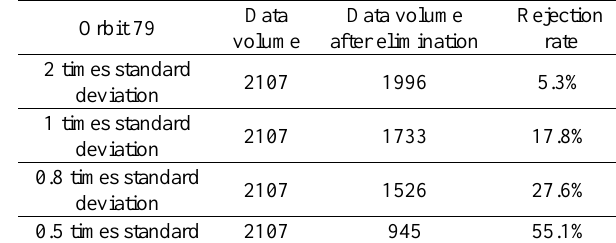
Figure 3. Outliers elimination results of different standard deviation. (a) eliminated by 2 times standard deviation, (b) eliminated by 1 times standard deviation, (c) eliminated by 0.8 times standard deviation, (d) eliminated by 0.5 times standard